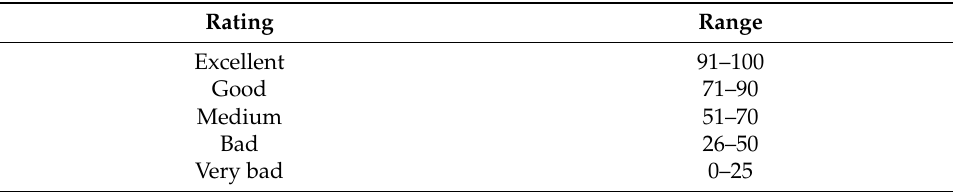
Table 6. Descriptor Words and WQI Value Ranges